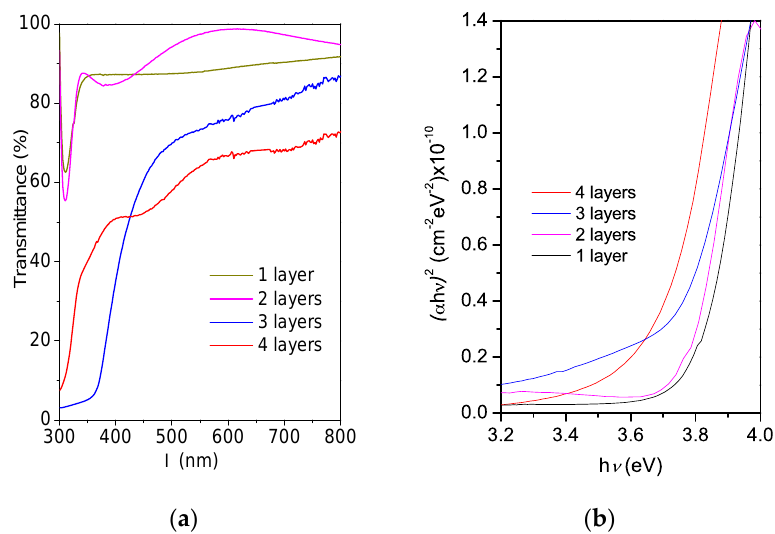
Figure 5. ( a ) Zn(O;OH)S thin-film transmittance as a function of the number of layers deposited by CBD. ( b ) Tauc plots and band-gap energy estimation for the Zn(O;OH)S thin films as a function of the number of layers deposited by CBD.